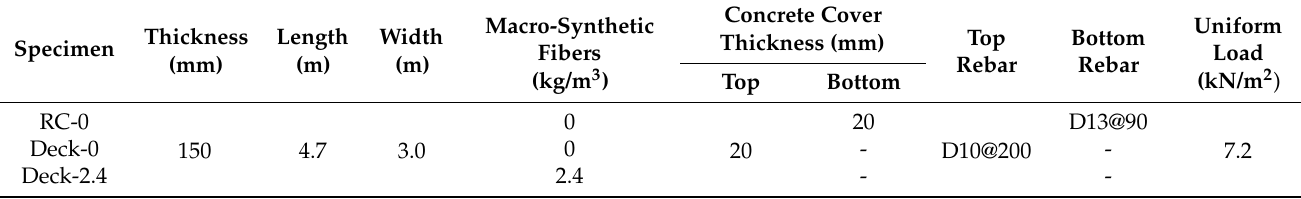
Table 6. Test specimen